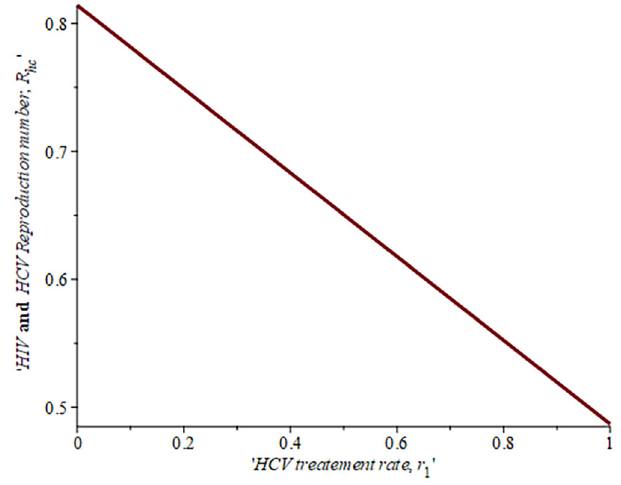
Figure 12. Impact of HCV treatment rate on HIV-HCV co-infection reproduction Figure 14 described the impact of testing on the HIV-HCV co-infection population. The plot shows that when (0.30) 30% of the co-infected individual is tested for HIV the reproduction number R ehc is0 : 916 91 : 6 % ð Þ , also if we test (0.6) 60% of the individual who are co-infected of their HIV first the R ehc reduces to 0.321 (32.1%). This shows that the more we test, the lower the risk of transmitting HIV and HCV.